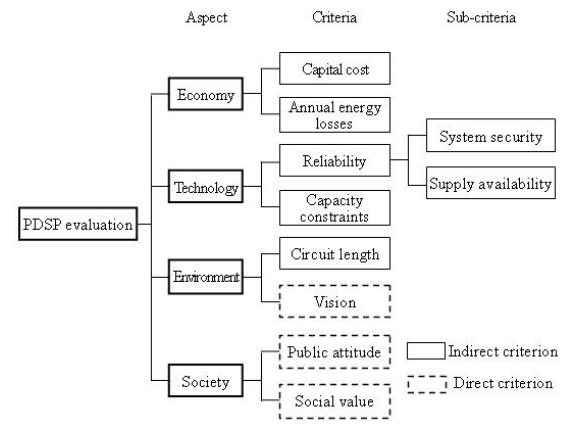
Fig. 1. A PDSP evaluation